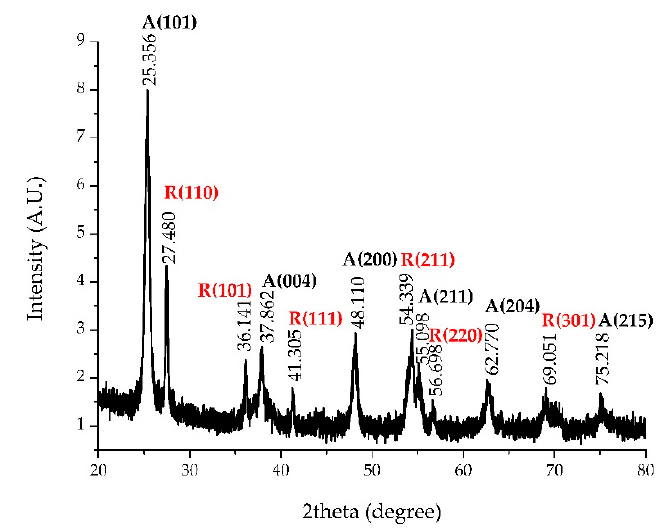
Figure 1. XRD spectrum of N-doped TiO 2 powder.